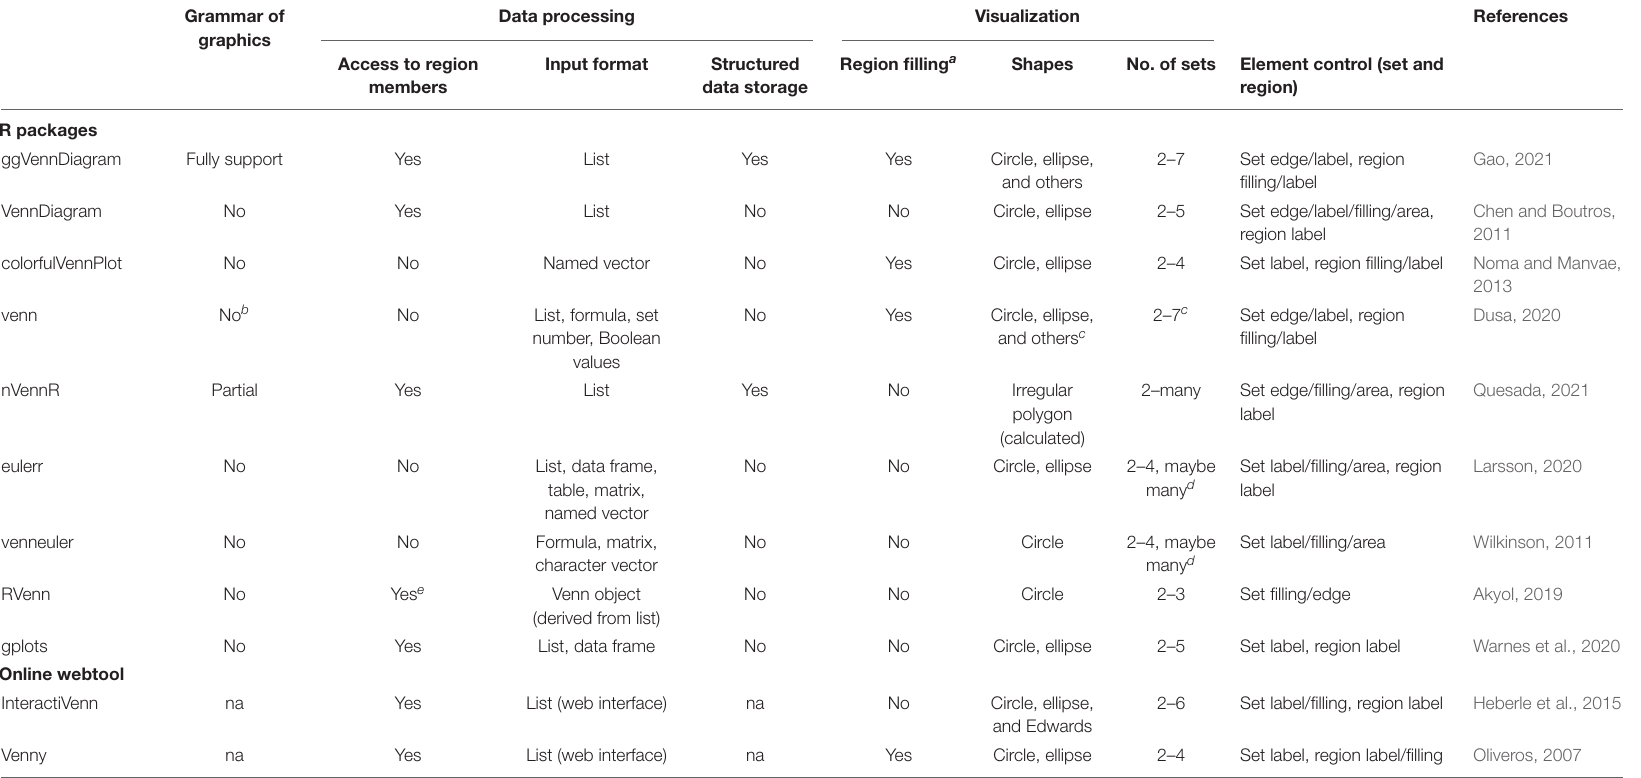
TABLE 1 | Feature comparisons of currently available Venn plot tools (R packages and web